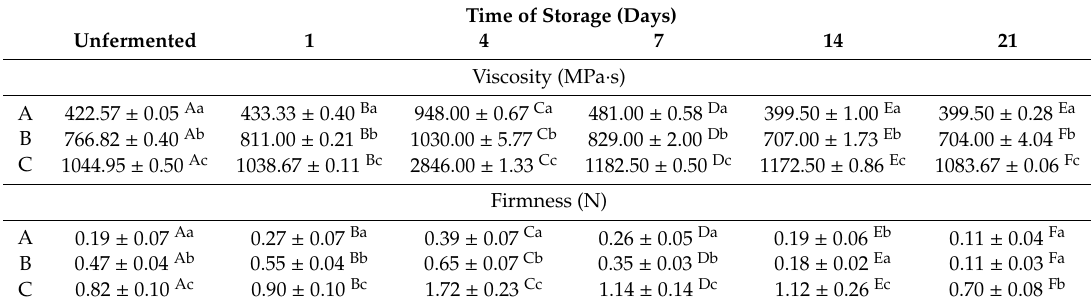
Table 5. Viscosity and firmness changes of the samples during storage. Time of Storage